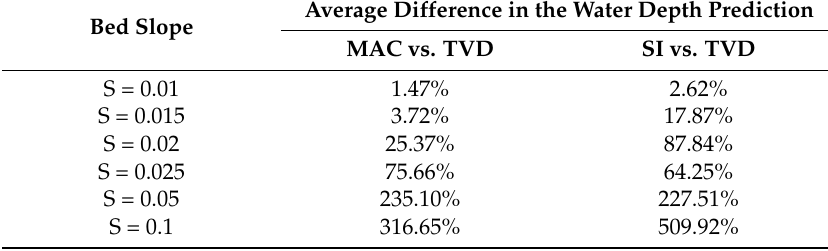
Table 1. Average difference in water depth predictions between the MAC and TVD, and SI and TVD model configurations for the idealised valley test case expressed in terms of percentage